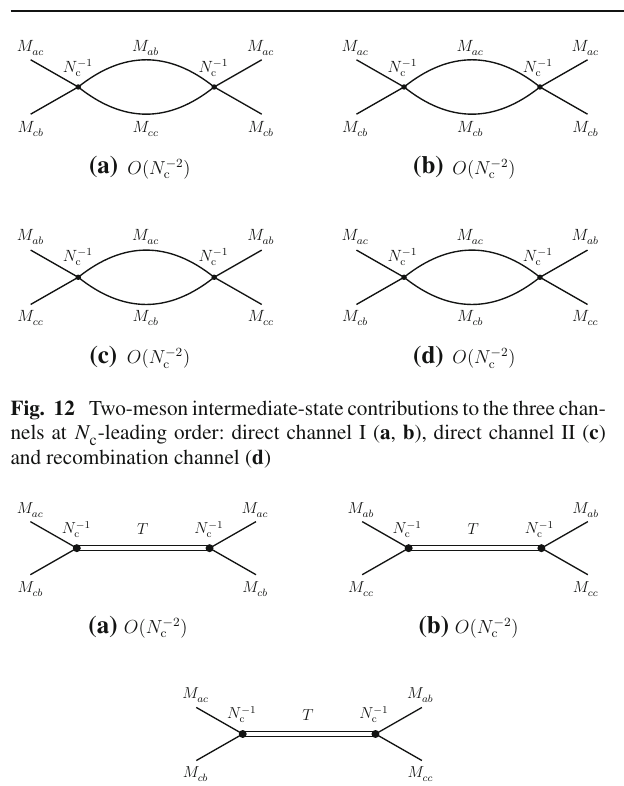
Fig. 13 Tetraquark-state contributions to the three channels at N c - leading order: direct channel I ( a ), direct channel II ( b ) and recom- bination channel ( c )